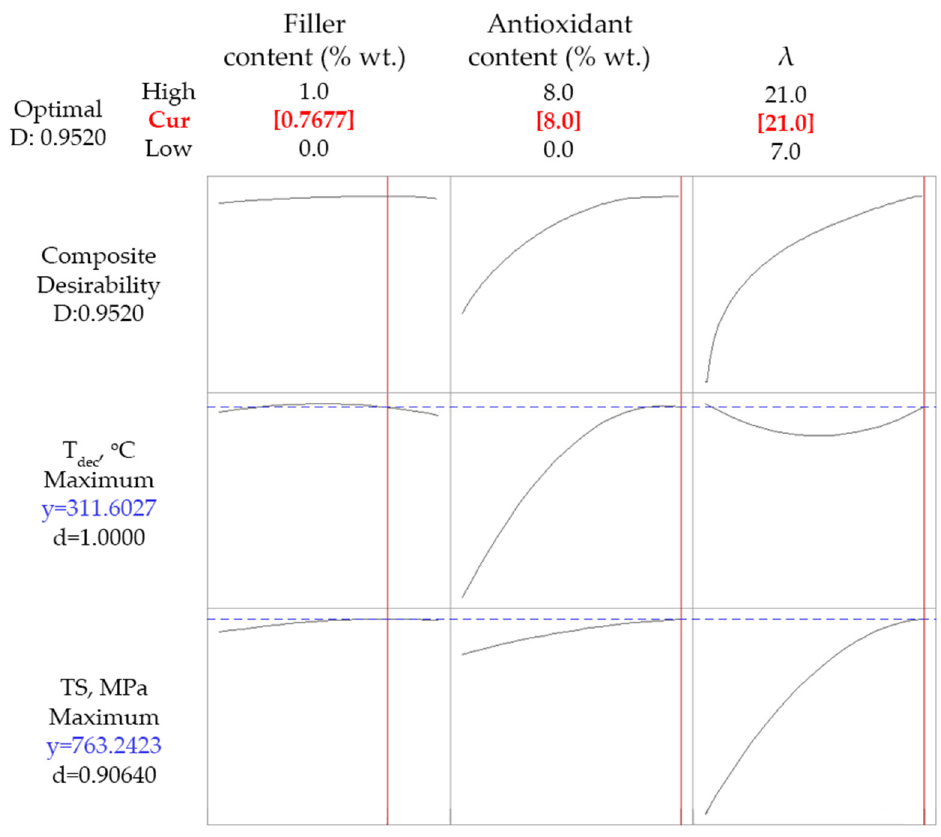
Figure 9. Optimization results targeting maximum TS and T dec for composites with SWCNTs.